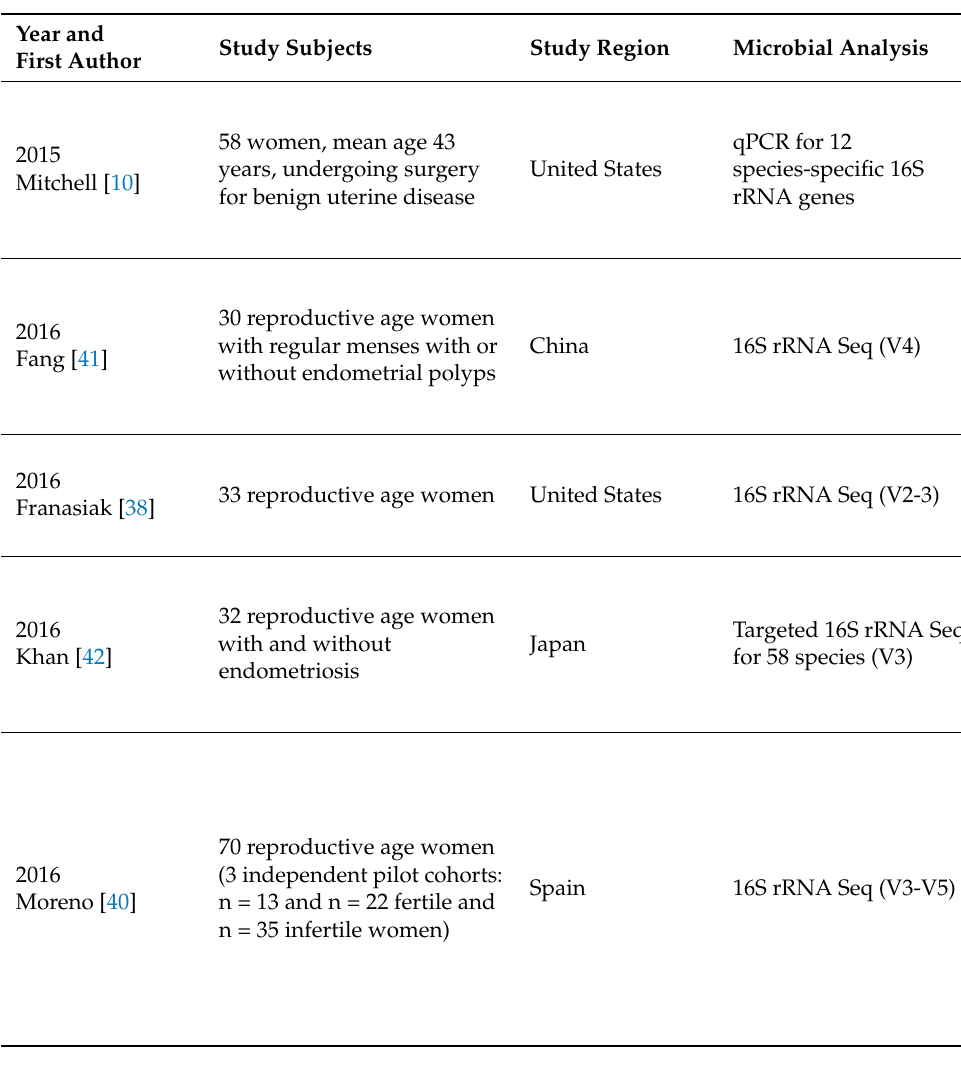
Table 1. Summary of studies analyzing the upper FRT microbiome, including uterine cavity and endometrium, ovaries, fallopian tubes, and peritoneal